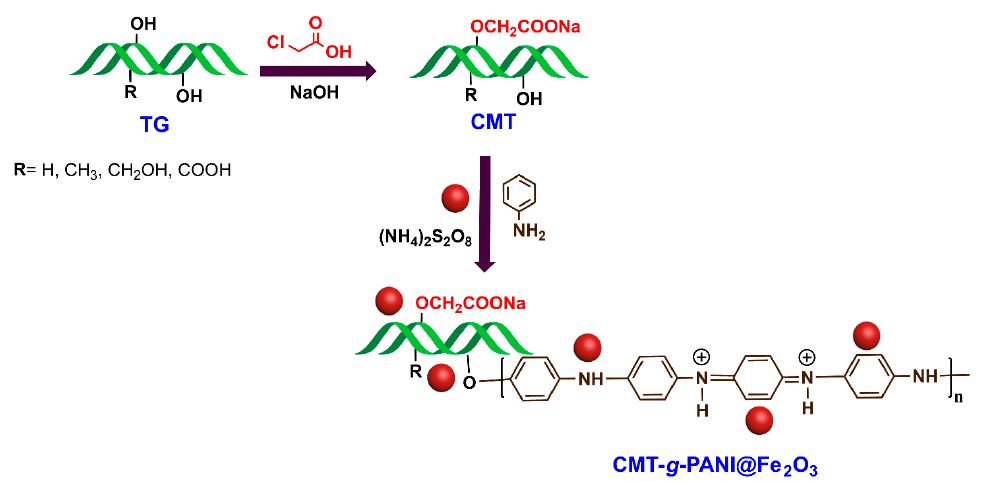
Figure 1. Schematic illustration of the preparation of carboxymethyl tragacanth gum (CMT) and carboxymethyl tragacanth gum- grafted -polyaniline@ γ Fe 2 O 3 (CMT- g -PANI@Fe 2 O 3 ) bionano-compsite.